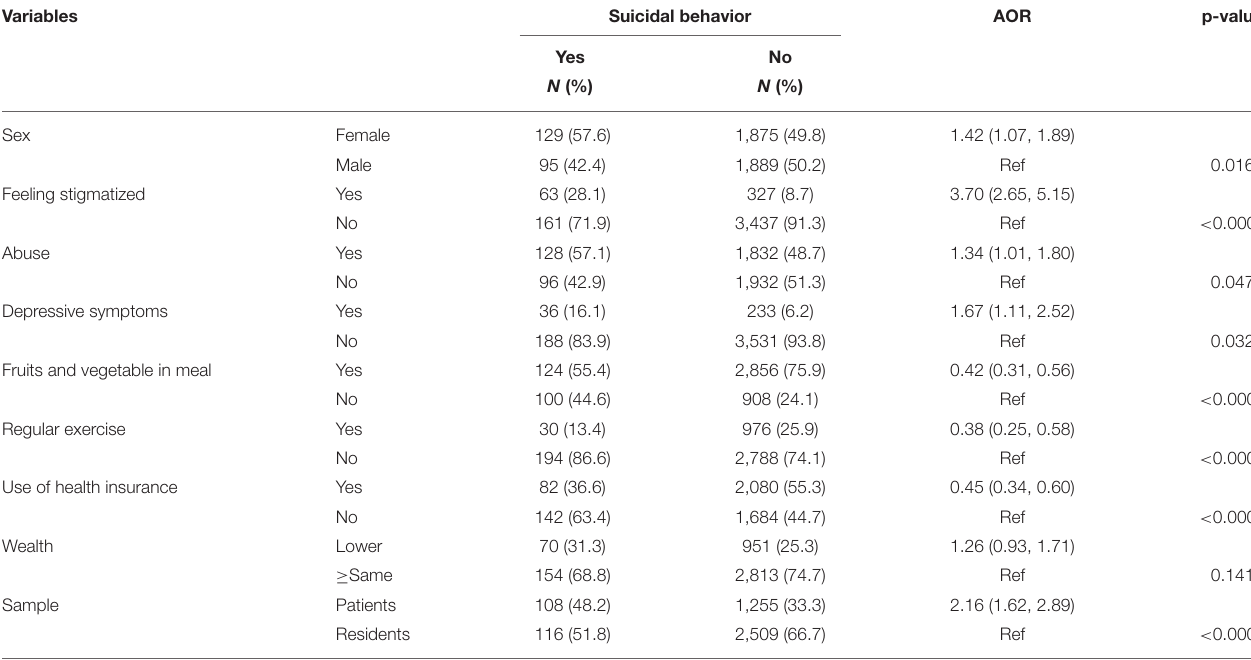
TABLE 3 | Multivariable logistic regression of risk factors associated with suicidal behavior in the whole sample ( N = 3,988).